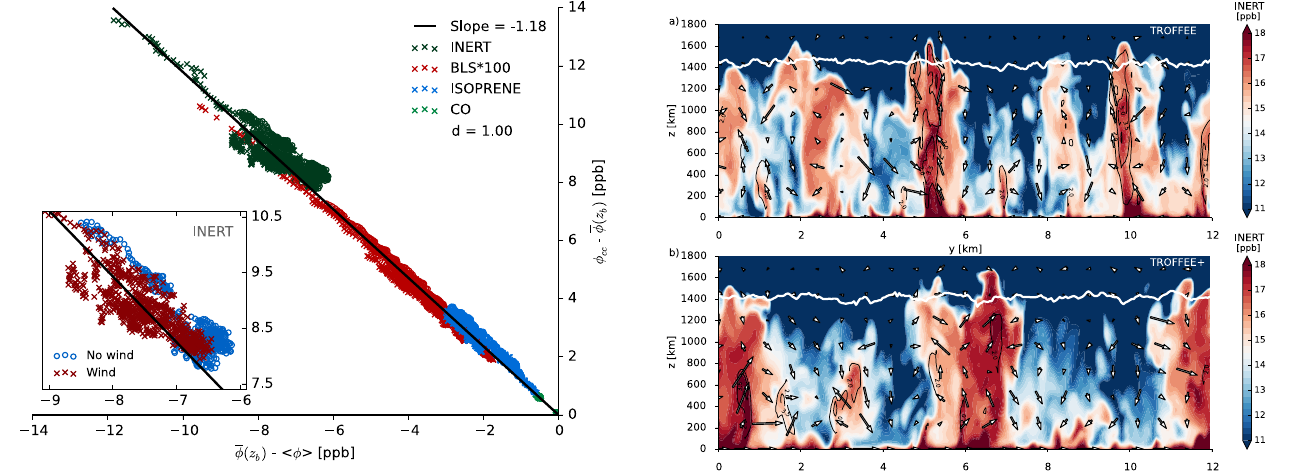
Figure 8. Vertical cross sections of INERT for the TROFFEE case for (a) a free convection situation and (b) a wind situation. The white arrows indicate wind vectors of the v and w component. In panel (b) , the mean horizontal wind is subtracted from the flow to identify the vertical patterns. The white horizontal line around 1400m denotes the ABL height, which is calculated using the threshold gradient method. In black, contour lines are shown for w , starting at a lower limit of 2ms − 1 with intervals of 1.5ms − 1